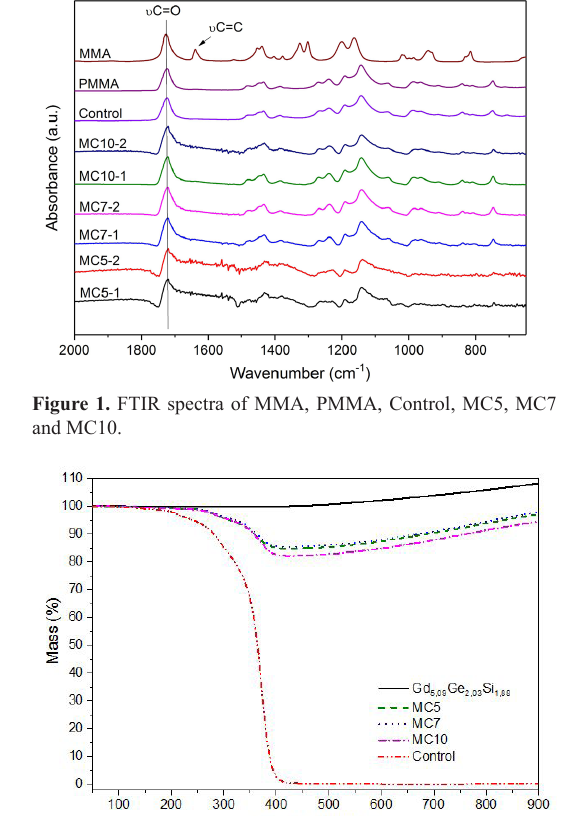
Figure 2. Thermogravimetric curve of Gd MC5, MC7, MC10 and